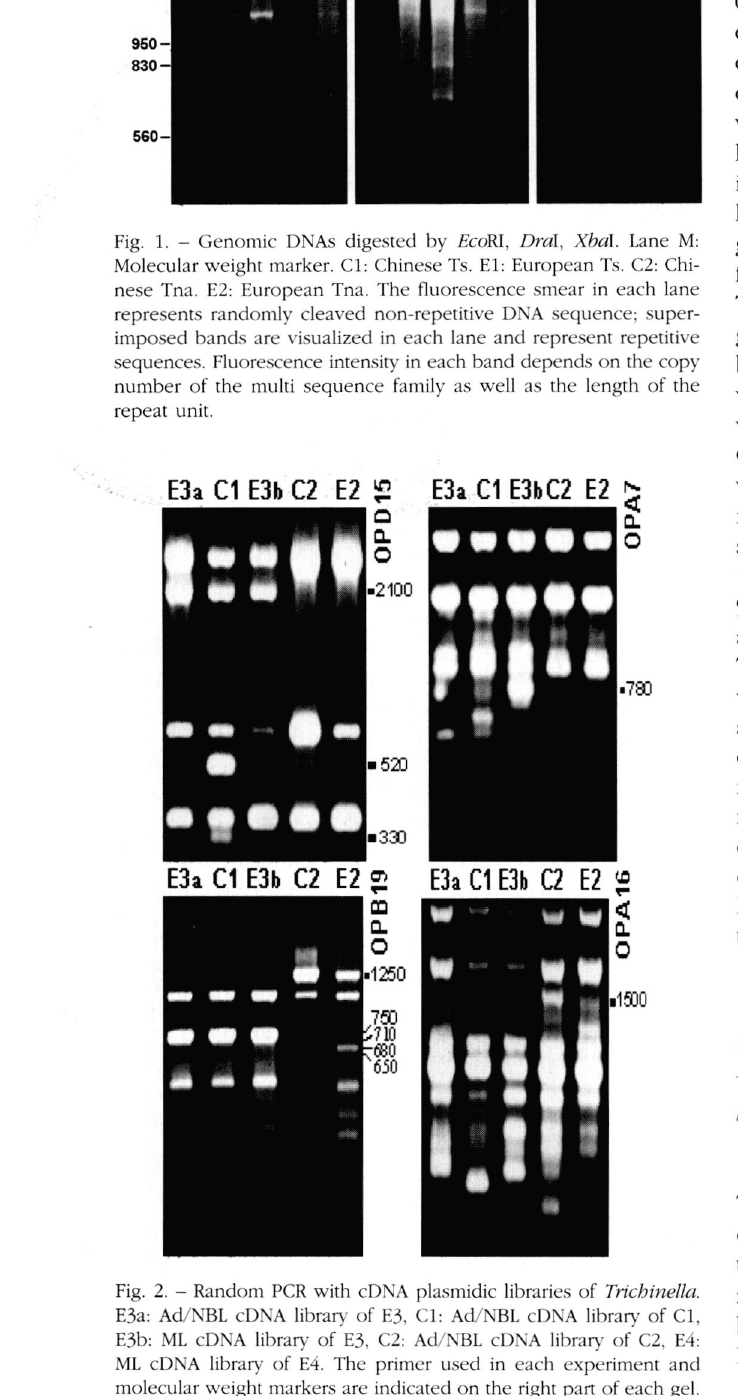
Fig. 2. - Random PCR with cDNA plasmidic libraries of Trichinella. E3a: Ad/NBL cDNA library of E3, C1: Ad/NBL cDNA library of C1, E3b: ML cDNA library of E3, C2: Ad/NBL cDNA library of C2, E4: ML cDNA library of E4. The primer used in each experiment and molecular weight markers are indicated on the right part of each